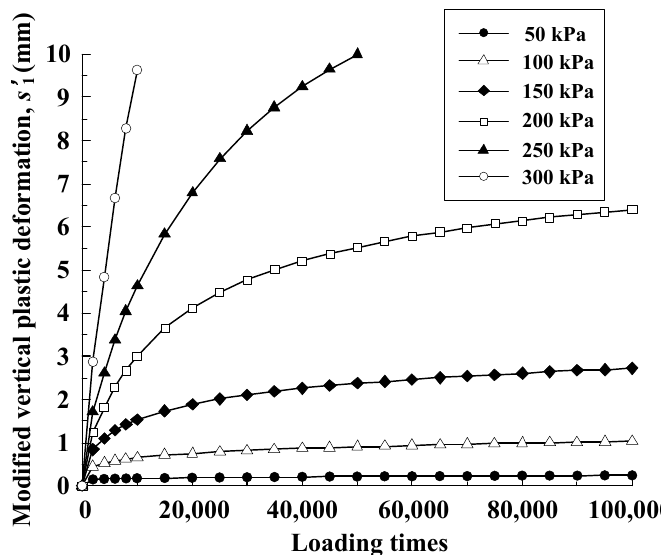
Figure 11. Modified plastic deformation against loading times for Model 1.